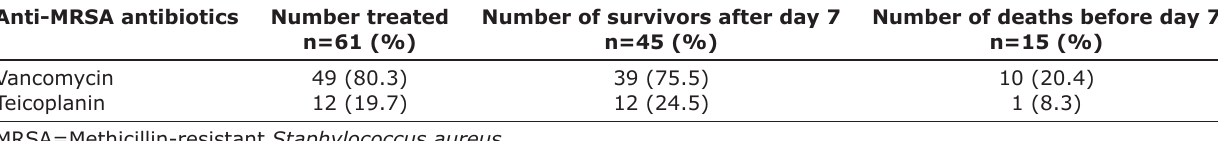
Table-1: Treatment outcome of vancomycin and teicoplanin regarding 7 th day mortality and survival rate. Anti-MRSA